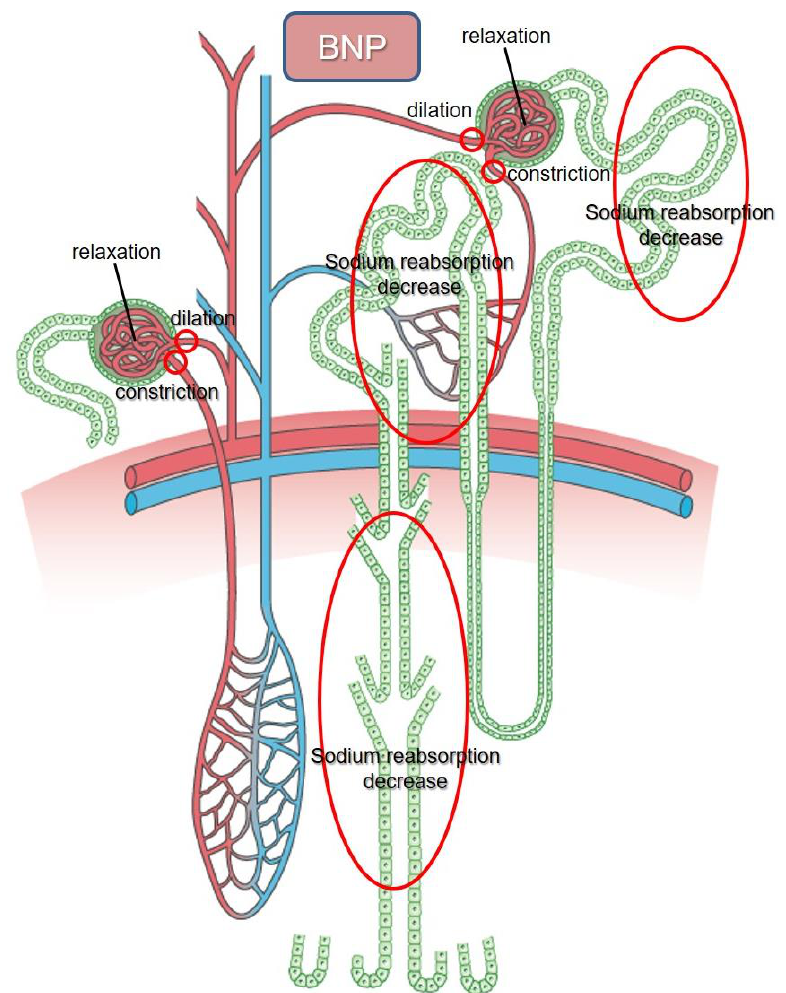
Figure 1. The interaction site of BNP in the nephron. BNP: brain natriuretic peptide.